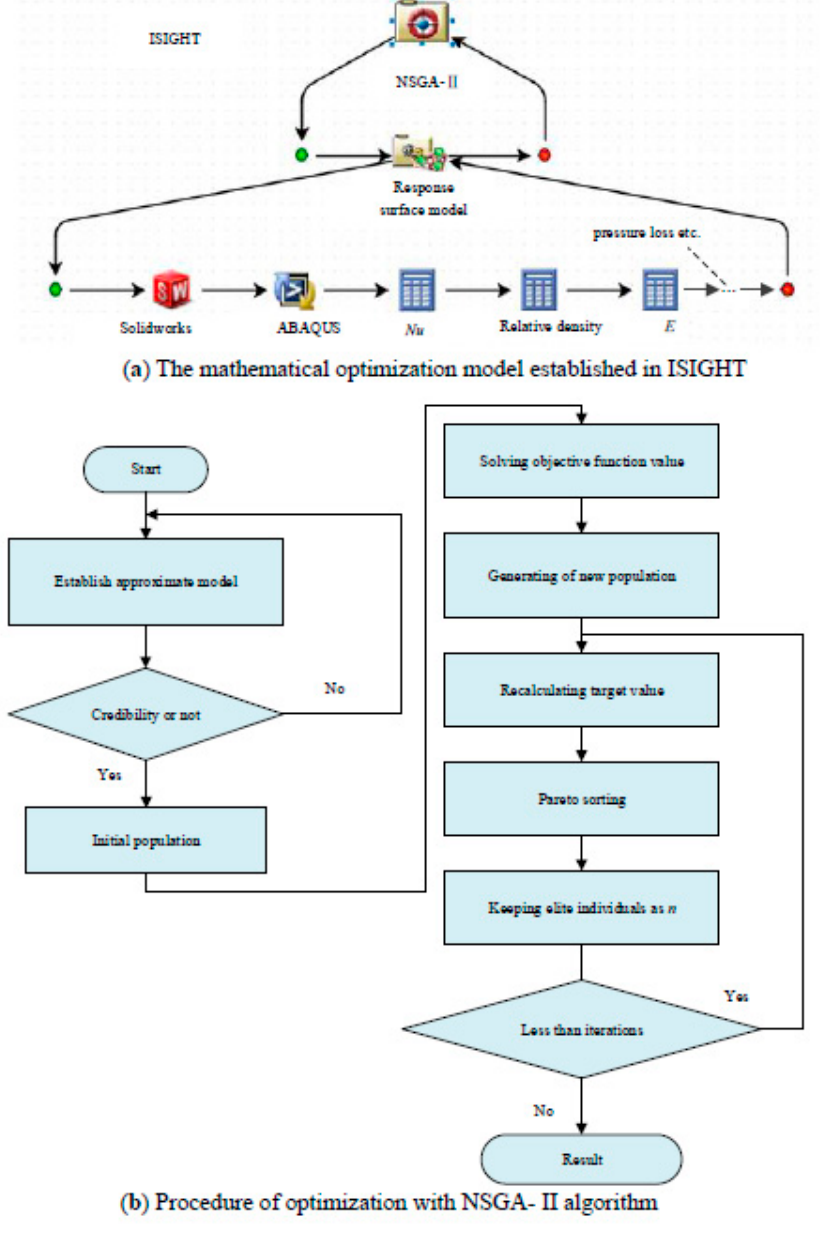
Figure 6. Mathematical optimization model establishment and the procedure of optimization: ( a ) The mathematical optimization model established in ISIGHT; and ( b ) procedure of optimization with NSGA- II algorithm . Table 2. Fitting accuracy of approximate models for PLS and XLS.